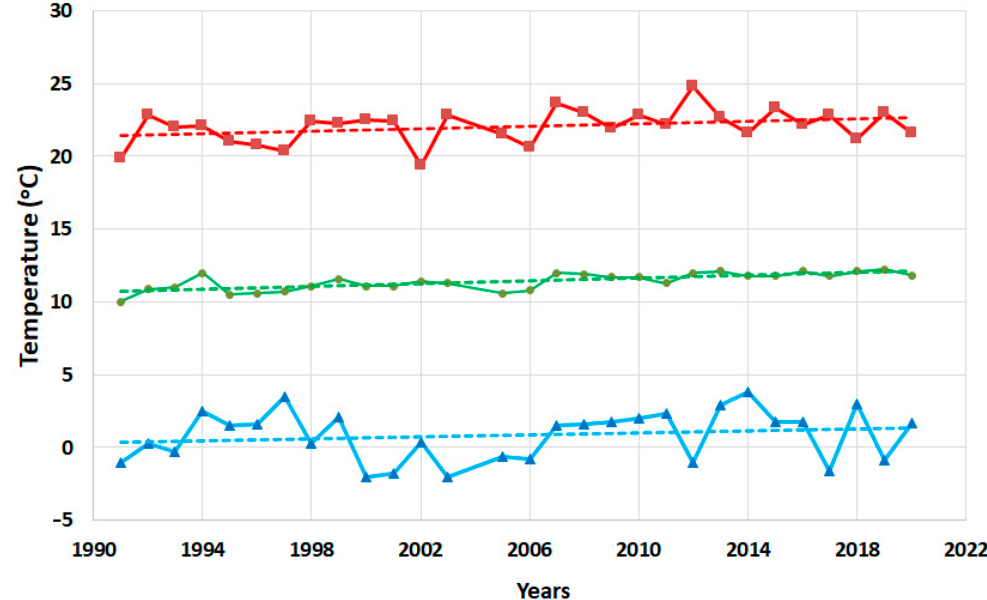
Figure 2. Values of temperature from 1990 to 2020 in Pretor station; green line: annual mean; red line: maximal mean monthly; blue line: minimal mean monthly. Source data: National Hydrometeorological Service of North Macedonia.